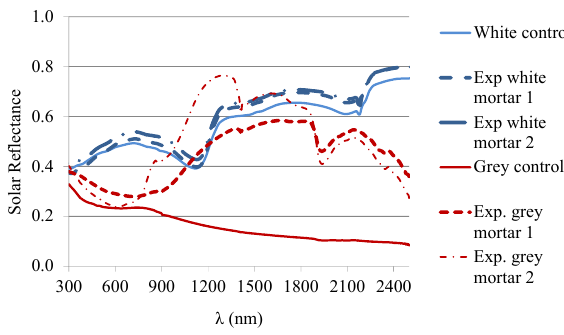
Figure 1. Solar reflectance of experimental white and coloured high-reflective mortars compared with the relevant matrix without cool